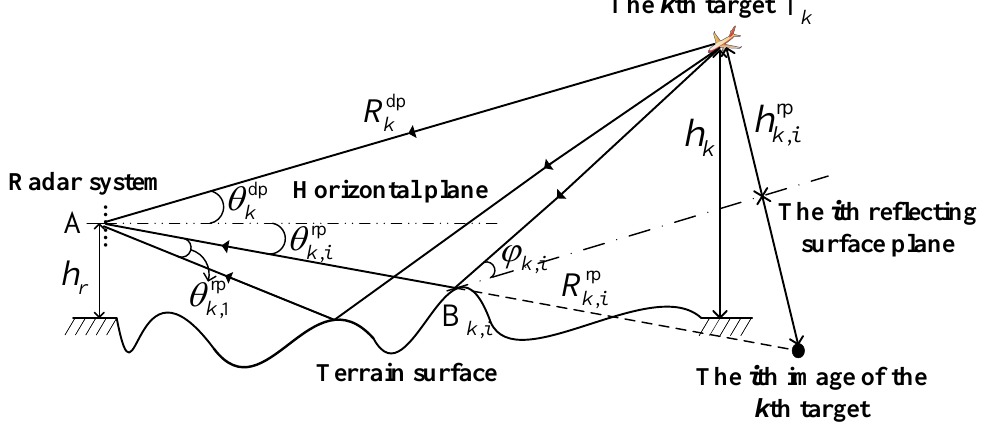
Figure 1. The improved multipath propagation model for a low-angle target localization scenario, where the dash-dotted line denotes the i th reflecting surface plane corresponding to the k th